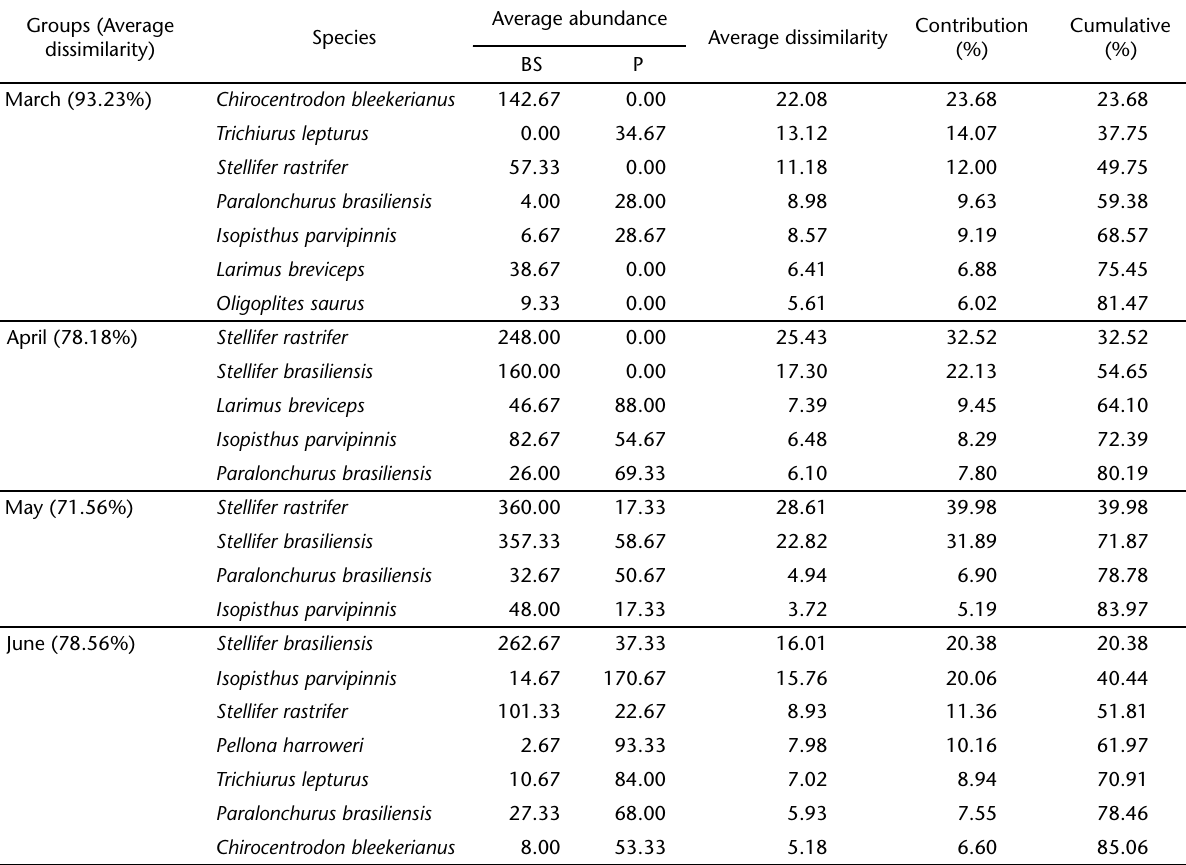
Table III. SIMPER results showing the average abundance, average dissimilarity and the percentage contribution of major fish species in the monthly average dissimilarity between Balneário Barra do Sul (BS) and Penha (P). Groups (Average